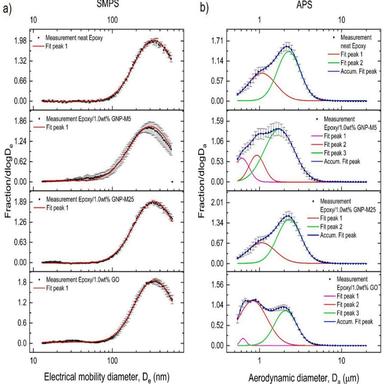
Fitted particle size distributions (PSDs) form abraded neat epoxy, Epoxy/1.0 wt% GNP-M5, Epoxy/1.0 wt% GNP-M25, Epoxy/1.0 wt% GO from 3 measurements per sample: a) measured by scanning mobility particle sizer (SMPS, size range 13–573 nm) and b) measured by aerodynamic particle sizer (APS, size range 0.542–20 μm). For comparison, we show data from Epoxy, Epoxy/1.0 wt% GNP-M25 and Epoxy/1.0 wt% GO, that was also used in our previous study (Netkueakul et al. 2020).